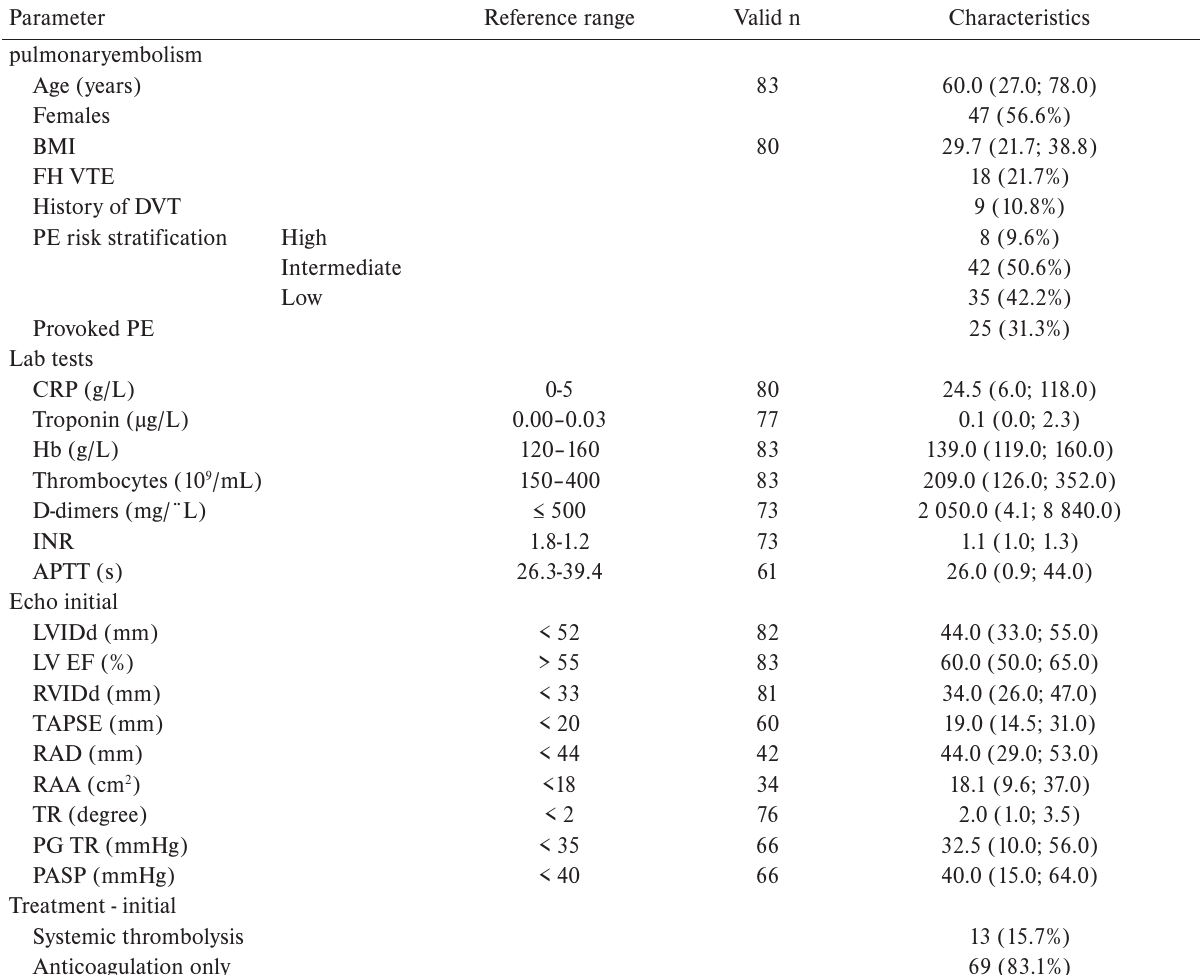
Table 1. Patient characteristics at